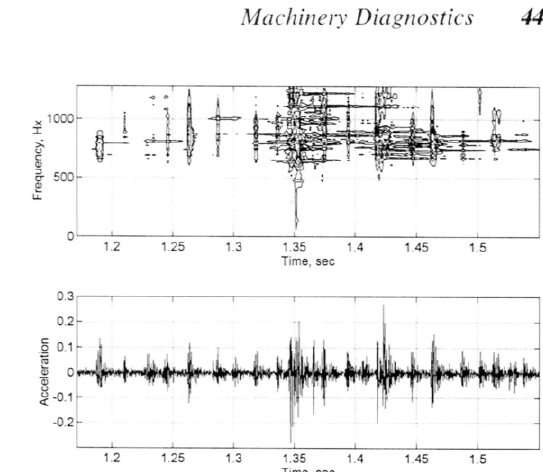
FIGURE 9 Contour plot and acceleration-time his tory of CWD of crane gearbox.